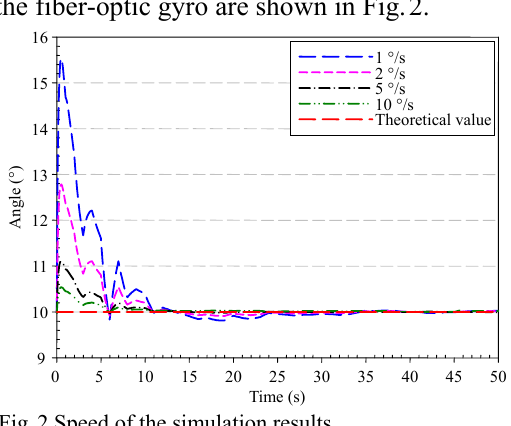
Fig. 2 Speed of the simulation